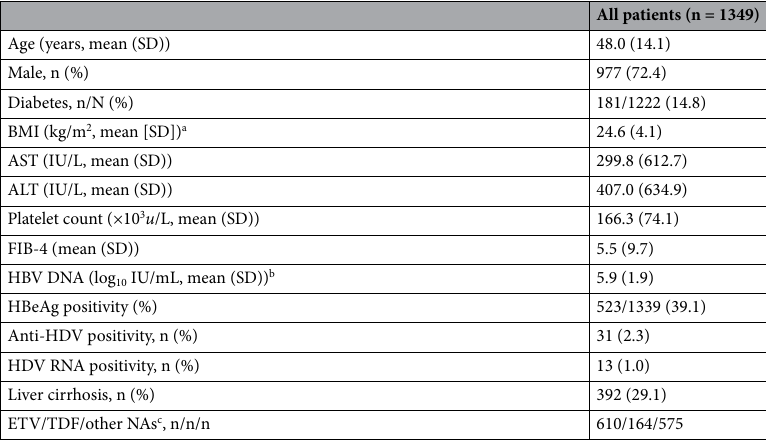
Table 1. Characteristics of the 1349 chronic hepatitis B patients preparing for NAs treatment. SD: standard deviation; BMI: body mass index; AST: aspartate aminotransferase; ALT: alanine aminotransferase; HBV: hepatitis B virus; HDV: hepatitis D virus; HBeAg: hepatitis B e-antigen; FIB-4: fibrosis-4 index; NAs: nucleoside/nucleotide analogues. a n=1309. b n=1346. c Included lamivudine (n = 401), telbivudine (n = 61), adefovir (n = 34), or NAs combination